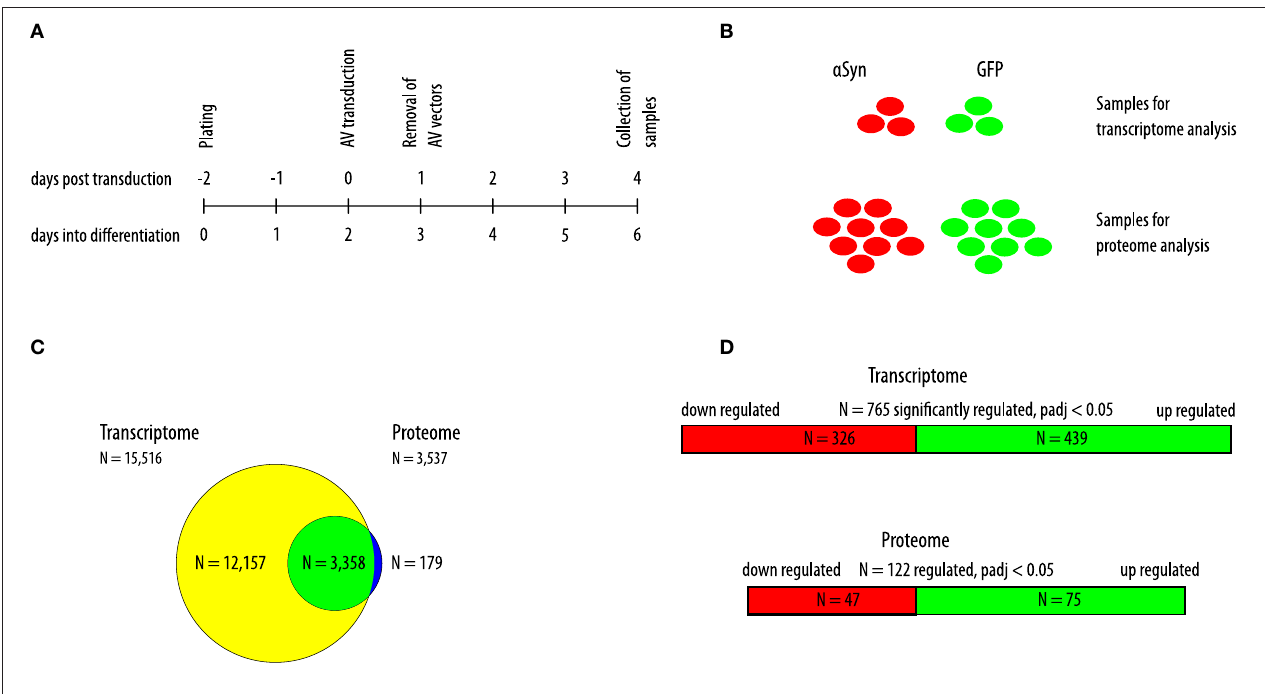
FIGURE 1 | Description of study design and samples. (A) Schematic of the experimental design. Cells were transduced 2 days into the differentiation process and collected 4 days after transduction. AV, adenoviral vectors. The upper timeline indicates days post transduction; the lower timeline indicates days into the differentiation process. (B) In total, three samples of α Syn-overexpressing cells and GFP-expressing cells were collected for the transcriptome analysis, and nine samples of α Syn-overexpressing cells and GFP-expressing cells were collected for the proteome analysis. (C) Overlap between detected genes in the transcriptome analysis and corresponding proteins in the proteome analysis. N = 15,516 transcripts were detected and 3,537 proteins. The yellow circle shows items exclusively detected in the transcriptome ( N = 12,157). The green circle indicates items detected in both, the transcriptome and the proteome ( N = 3,358). The blue circle indicates items exclusively detected in the proteome ( N = 179). (D) Depiction of differentially regulated transcripts (an upper panel) and proteins (a lower panel) with an adjusted p -value < 0.05 (Benjamini-Hochberg false-discovery rate). Red indicates downregulation. Green indicates